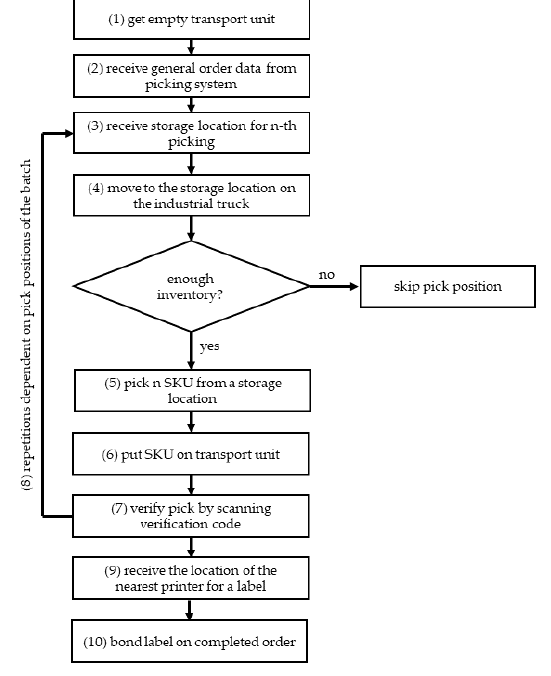
Figure 2. Manual picking process for picker-to-part scenarios of the case study.